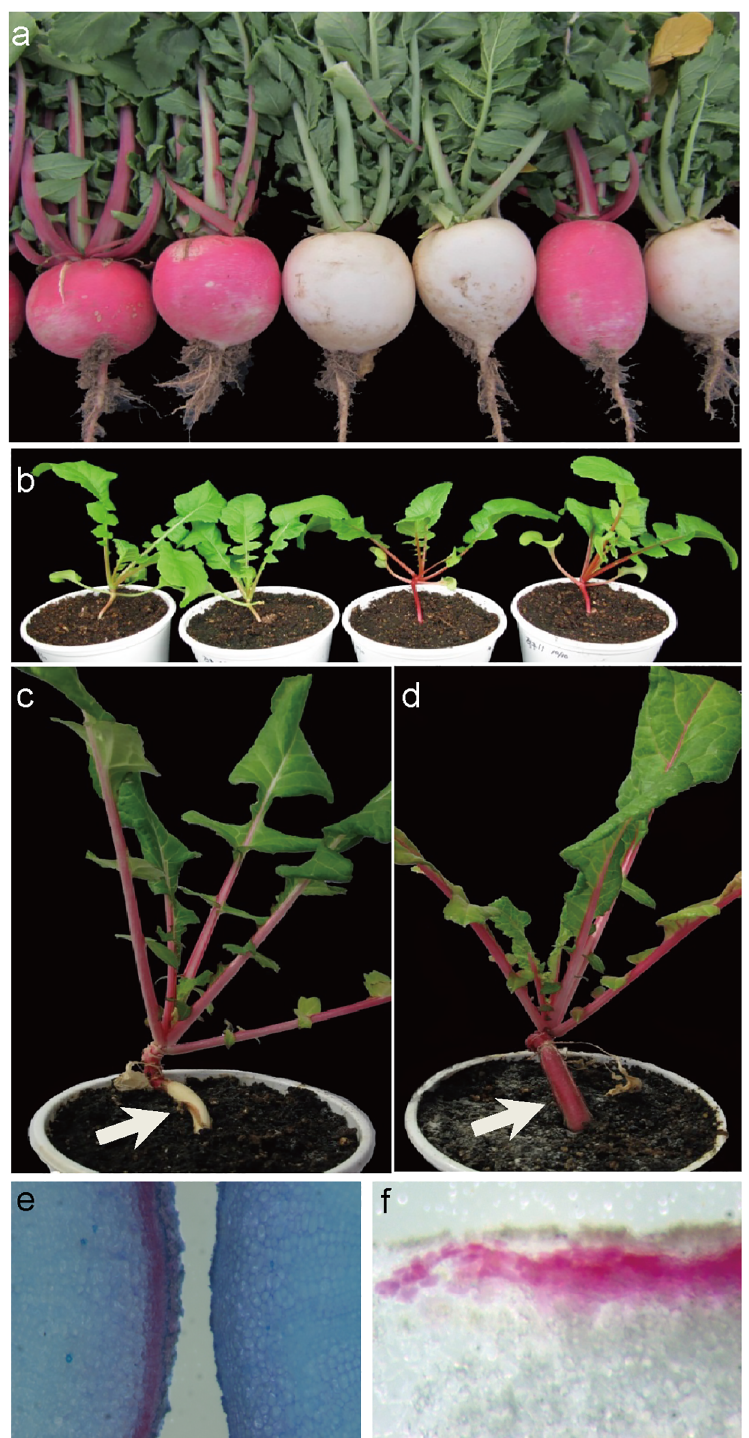
Fig 1. Phenotypes of red and white root skin radishes. (a) Root skin color phenotypes of segregating F 2 individuals grown in a field. (b) Hypocotyl skin colors of F 3 plants at 21 days after planting (DAP). Note that in many instances, the hypocotyl and petiole colors are already separated but they are not always identical to the root skin color. (c, d) White and red root skin colors of F 3 plants at 120 DAP, when root and hypocotyl thickening is in progress (e) Stereomicroscopic images of transverse sections of the red (left) and white (right) roots stained with toluidine blue O.